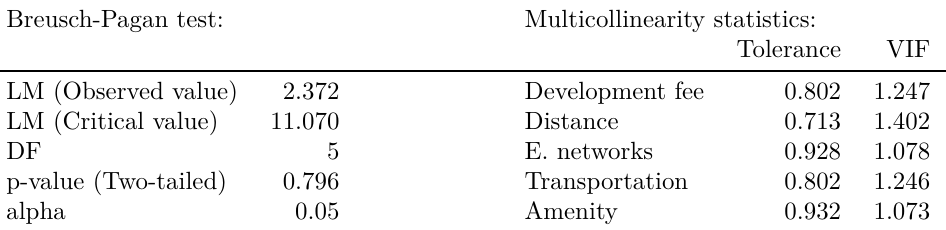
Table A.1: Heteroscedasticity and multicollinearity tests of Model 1 results